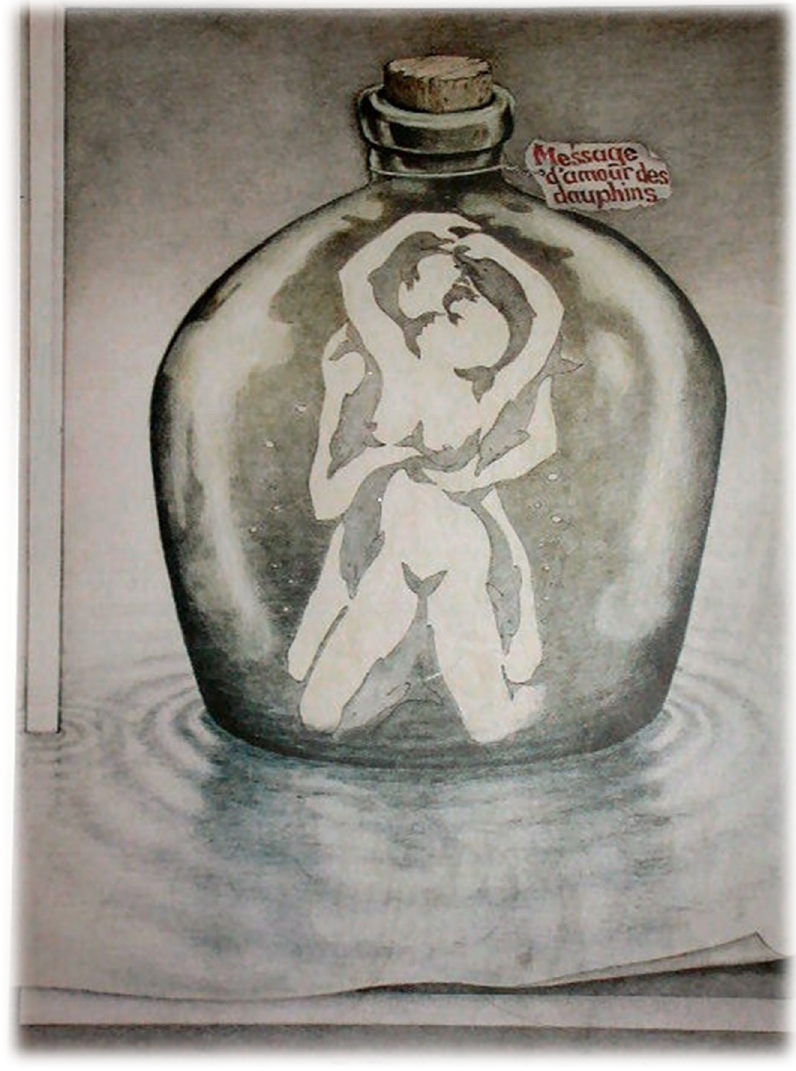
Figure 12. Dolphins (fish) in the white spaces of a bottle.